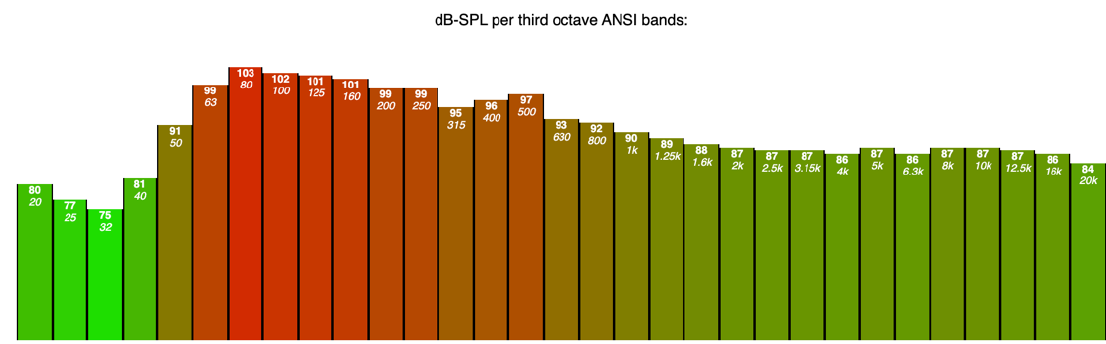
Figure 6. SPL per one-third octave band produced automatically by the system. In order to provide a first glance of third octave levels, building on previous